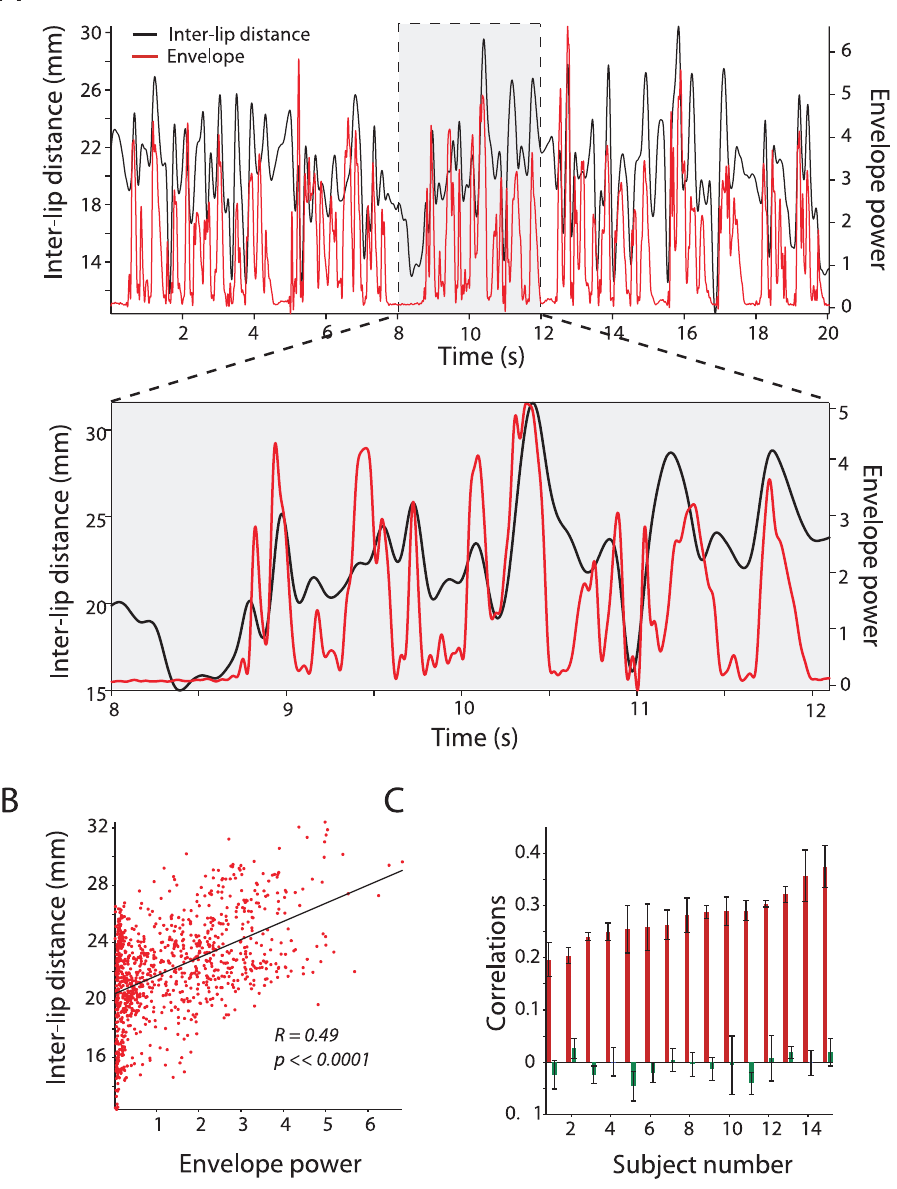
Figure 3. Average correlations between visual and auditory segments for longer speech materials. A - Top, Inter-lip distance and the auditory envelope for a single 20 second segment from a single subject in the X-ray database as a function of time. X –axes depict time in seconds. Y– axes on the left depict the distance between the lower and upper lip in millimeters. Y-axes on the right depict the power in the wideband envelope. Bottom, shows a zoomed in portion of the 8–12 second time segment of the same data shown in A. Clear correspondences are present between the inter-lip distance and the auditory envelope. B - Scatter plot of the envelope power and inter lip distance along with the corresponding regression line. Each red circle denotes a single point in the speech time series. Black line denotes the linear regression between the inter-lip distance and the envelope power. Correlation coefficient between auditory and visual components for this sentence was 0.49 (p , 0.0001). C - Average rank ordered intact correlations (red bars) and shuffled correlations (green bars) for the 15 subjects analyzed in the Wisconsin 6 ray database. X-axes depict subject number; Y- axes depict the correlations. Intact correlations for each subject were the average across all speech segments analyzed for that subject. Error bars denote standard error of the mean. Shuffled correlations were computed as an average correlation between all non-paired auditory envelopes and the inter-lip distance for each subject.